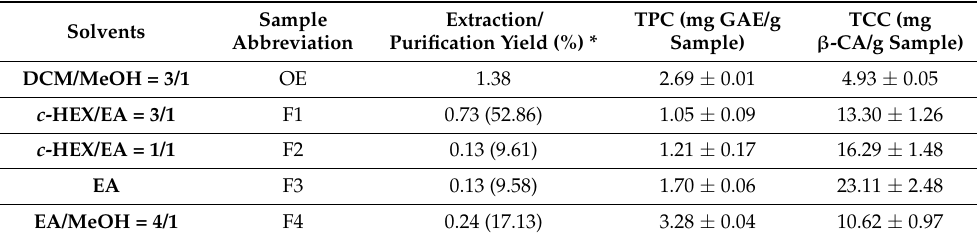
Table 1. Solvents used for preparation of samples, extraction and purification yields, total phenolic and carotene content of OE and F1 – F4 obtained from E . cavolini . Sample Extraction/ TPC (mg GAE/g TCC (mg Solvents β -CA/g Abbreviation Purification Yield (%) * Sample)